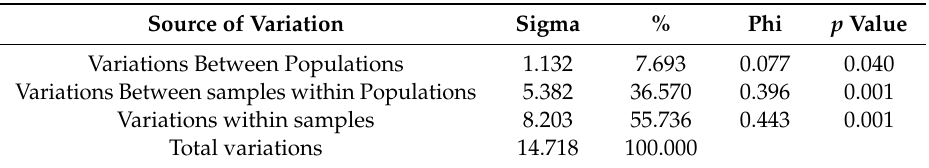
Table 1. AMOVA results: the sigma represents the variance, σ , for each population and the percent of the total variance explained by each source of variance. Phi provides the population di ff erentiation statistics. We would expect a higher Phi value to represent a higher amount of di ff erentiation. Sigma and Phi values are statistically